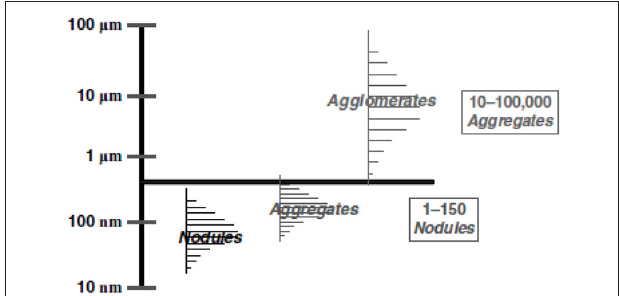
FIGURE 2 | Size distributions of carbon black structural entities * . Abstracted from McCunney et al. Pattys (in press) original figure in Pattys courtesy of Cabot